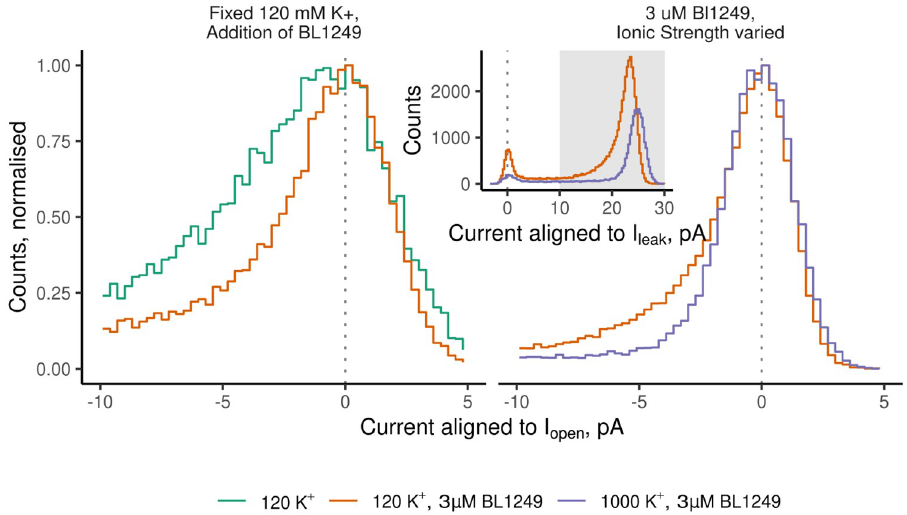
Fig 5. Combined action of BL1249 and high K + relieves open-state instability. Comparison of open-state peaks of TREK2 Δ M3 in different conditions. The open-state peaks of microscopic TREK2 recordings are often asymmetric or skewed (green trace, left). However, this is substantially reduced in the presence of BL1249 (red trace, left) and also in high ionic strength (purple trace, right). Data in the left panel was taken from a previously published dataset [17]. To compare the shape of the histograms the x-axis was aligned to the peak of the open-channel current, and the y-axis normalized to the peak. See insert for the raw amplitude histogram for the data plotted in the right panel. Membrane voltage was -100 mV except for the trace in 1000 mM K + (-60 mV). At this voltage the open-channel current was closest in amplitude to the matching recording in 120 K + .